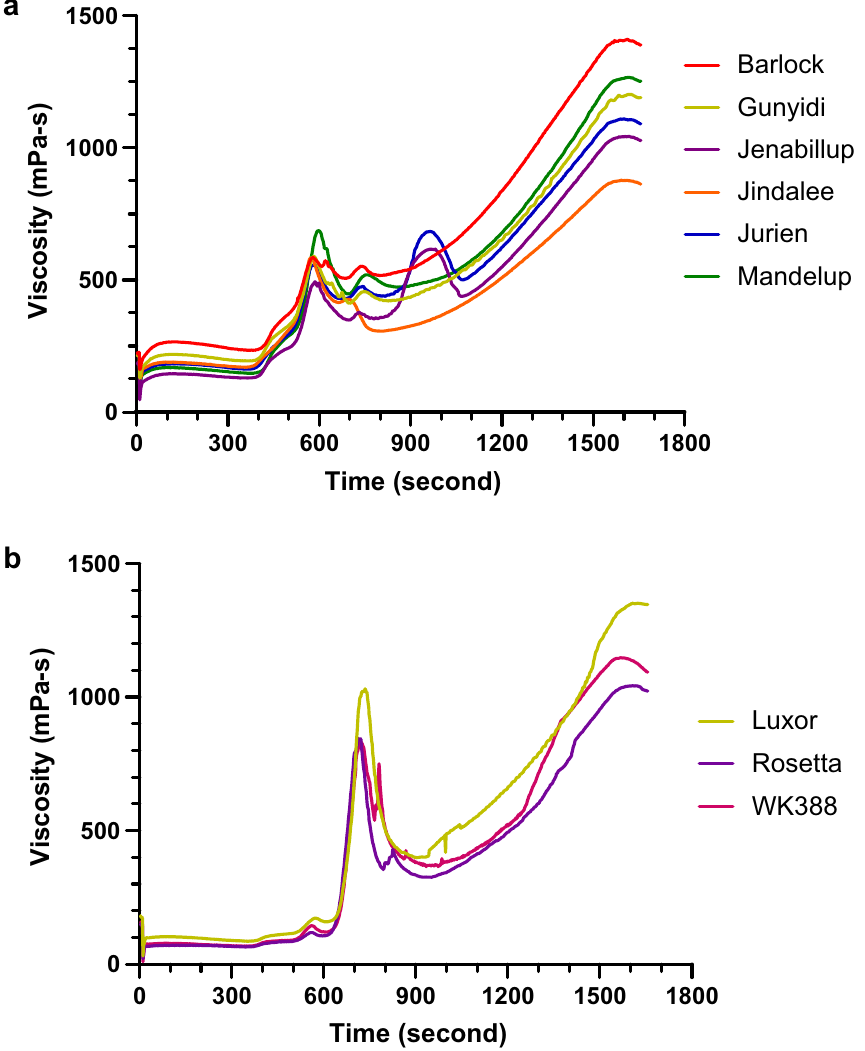
Figure 1. Pasting properties of different lupin cultivars’ flours, analyzed by RVA; where ( a ): RVA pattern of L. angustifolius cultivars and ( b ): RVA pattern of L. albus